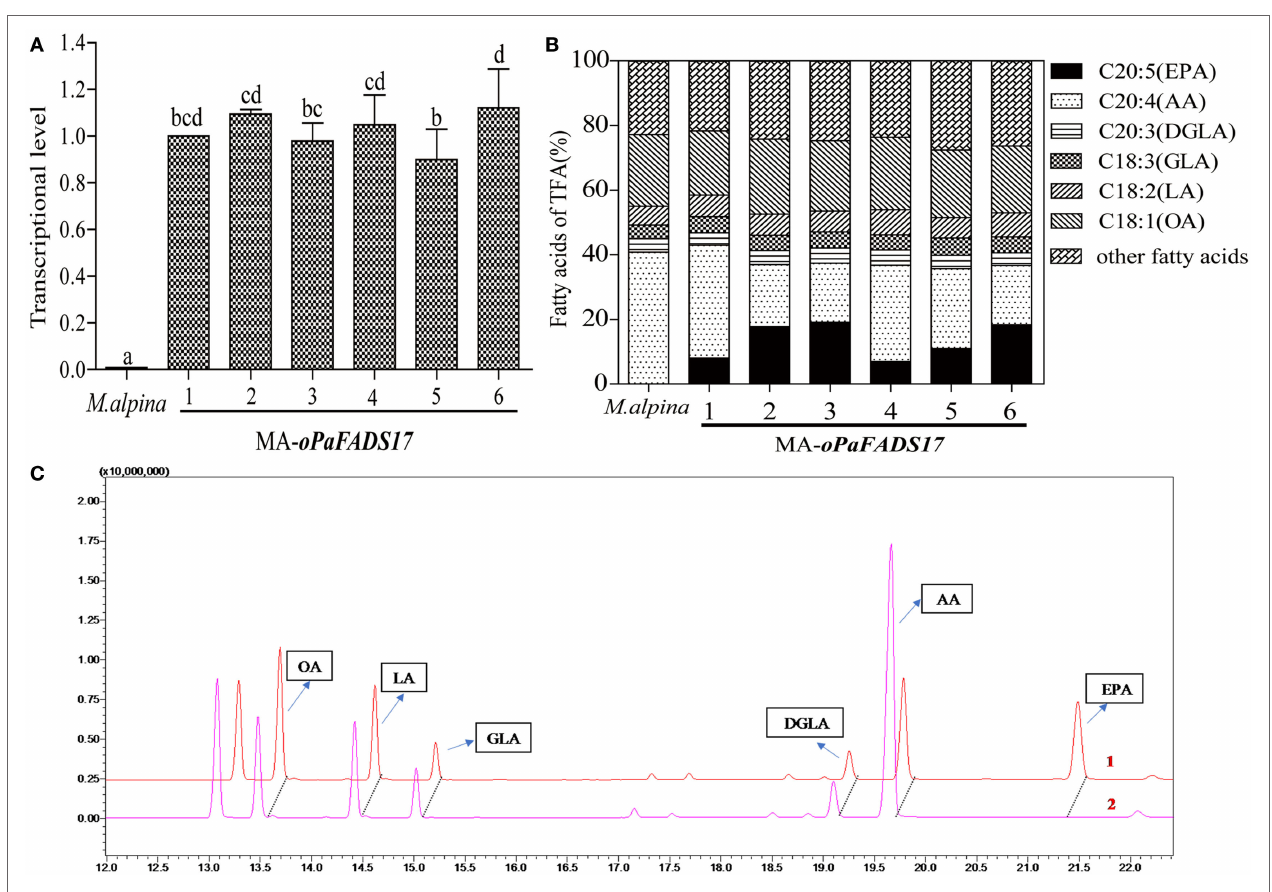
FigUre 6 | Relative expression levels of oPaFADS17 gene and fatty acid production and composition in Mortierella alpina transformants. (a) Relative expression levels; (B) fatty acid production and composition; and (c) gas chromatographs of the transformant (1) and wild-type M. alpina (2). All strains were cultivated in 100 mL of liquid broth medium for 7 days at